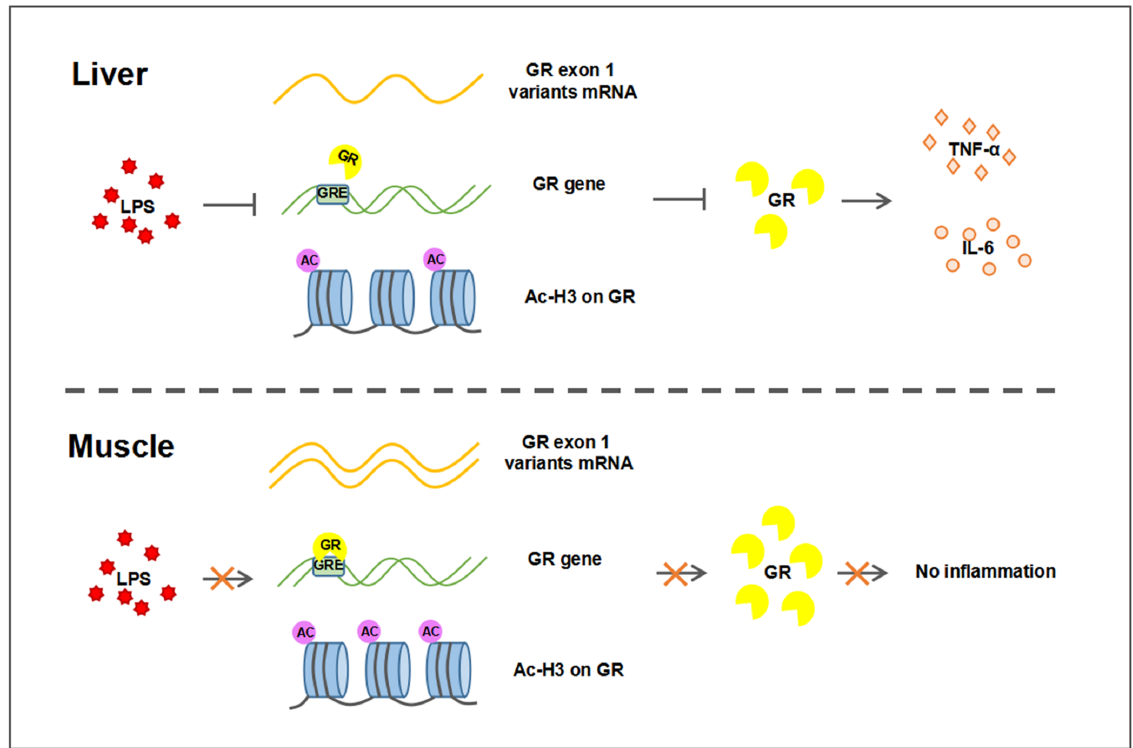
Figure 7. Different transcriptional regulation of GR in liver and muscle after LPS challenge. The decrease in GR expression in the liver after LPS stimulation was associated with the decrease in GR exon 1–4/5/6 expression, the binding of GR to GRE, and the acetylation of H3. Decreased GR results in increased expression of inflammatory factors TNF- α and IL-6, leading to an inflammatory response. In muscle, LPS did not affect the expression of GR, so there was no inflammatory response. Arrows for promotion, lines for inhibition, and crosses for no influence.